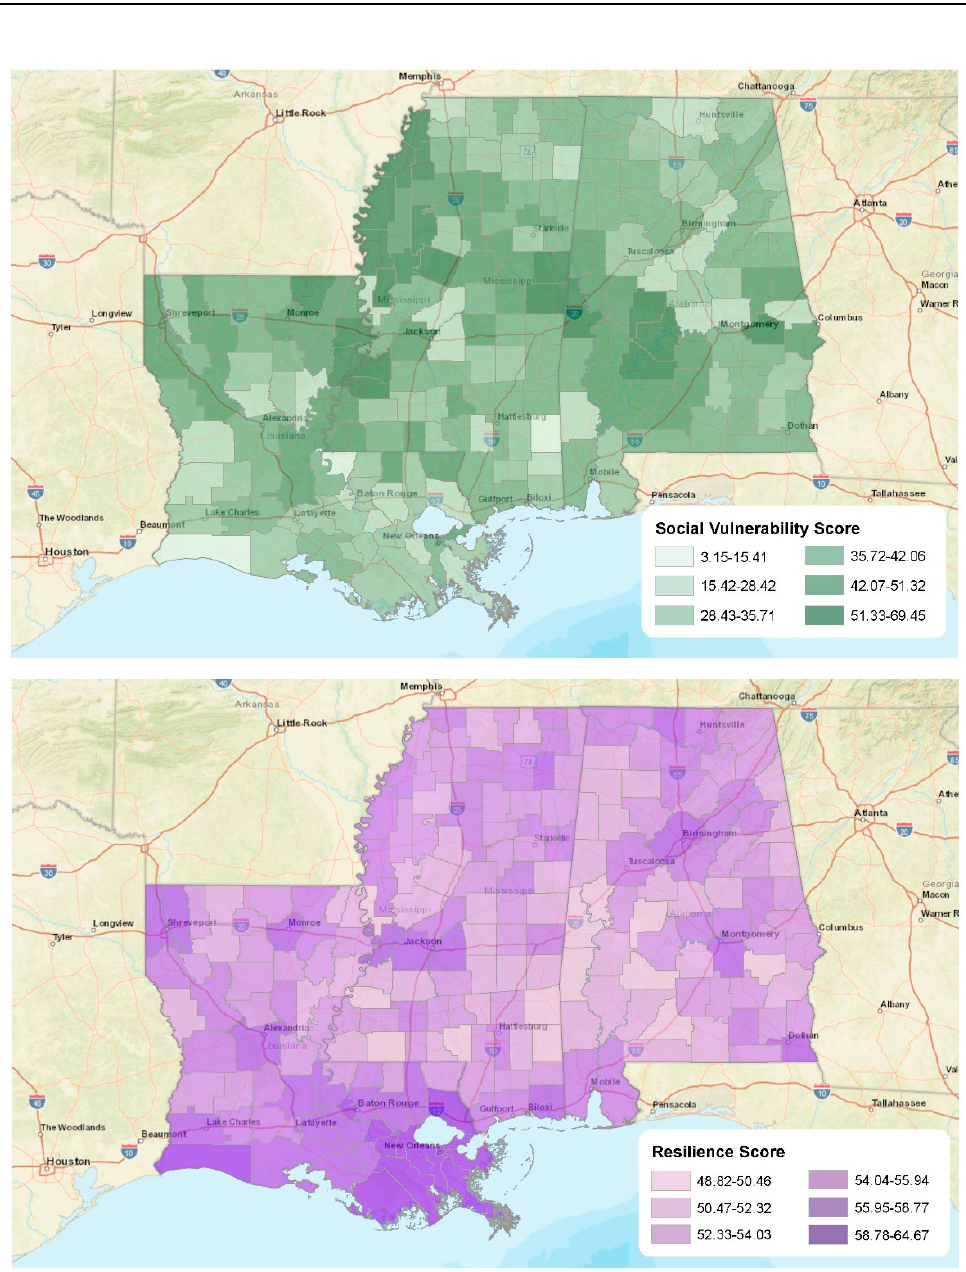
Figure 3. Social vulnerability and resilience